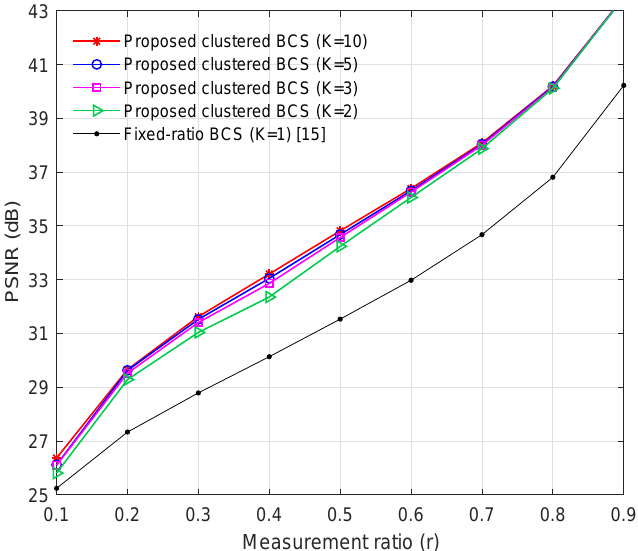
Figure 7. PSNR of the proposed clustered BCS for the various number of measurement matrices K when τ = 0.2 and β =